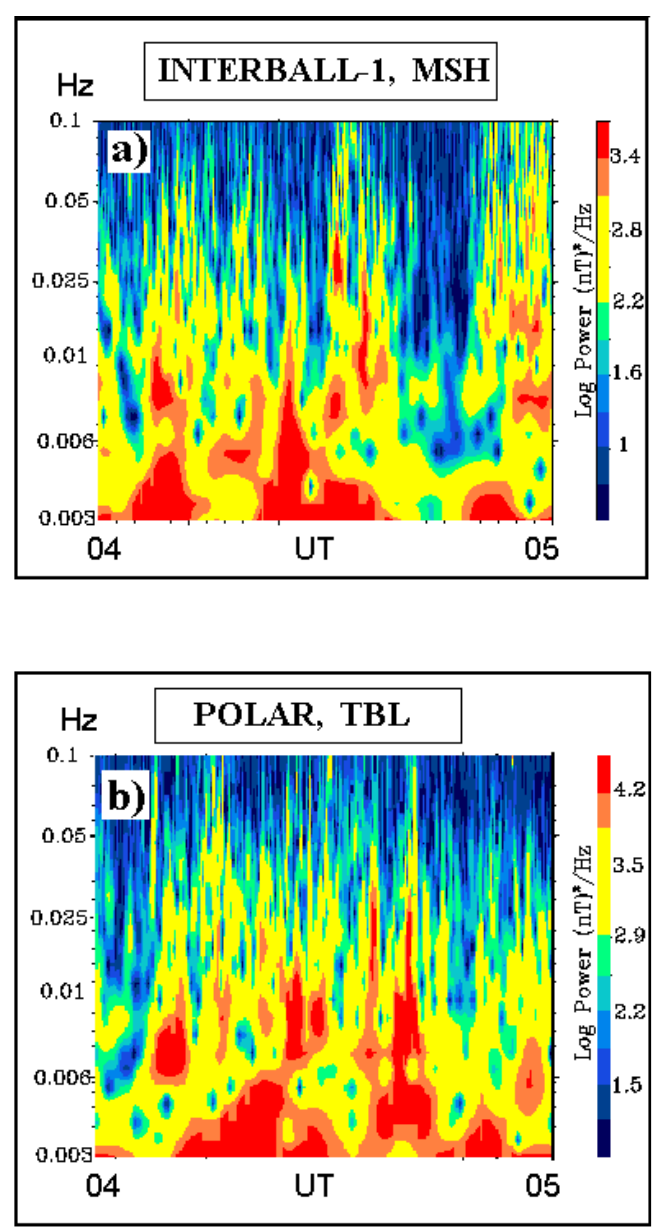
Fig. 5b. The same for Polar in the TBL (see also Plate